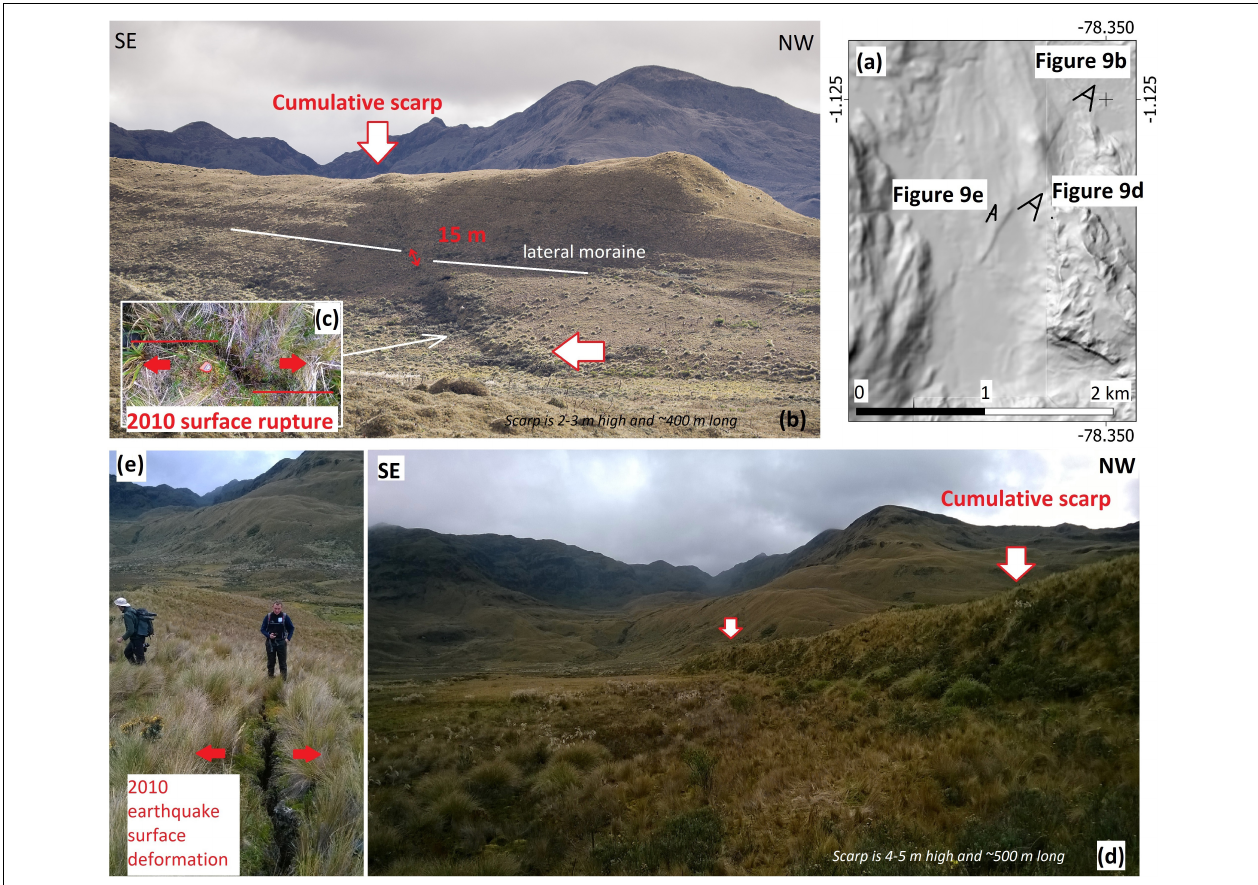
FIGURE 9 | (a) The Pisayambo Fault segment has ruptured during a small magnitude event (Mw ∼ 5) in 2010 along a clear cumulative fault scarp, leaving a 9 km long surface rupture (Champenois et al., 2017). (b,c) In the central section of the rupture, view of the 15 m offset of a lateral moraine, with evidences of 2010 30–40 cm right-lateral surface rupture; (d) illustration shows a high cumulative scarp in the south-central section, with coseismic surface deformation (open